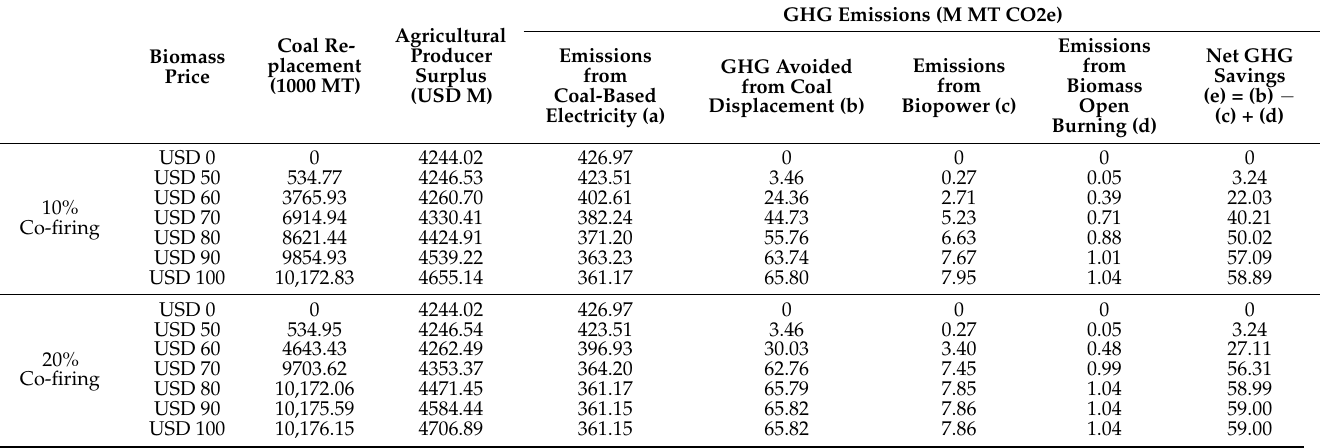
Table 1. GHG emissions and net GHG savings with various levels of biomass prices and co-firing